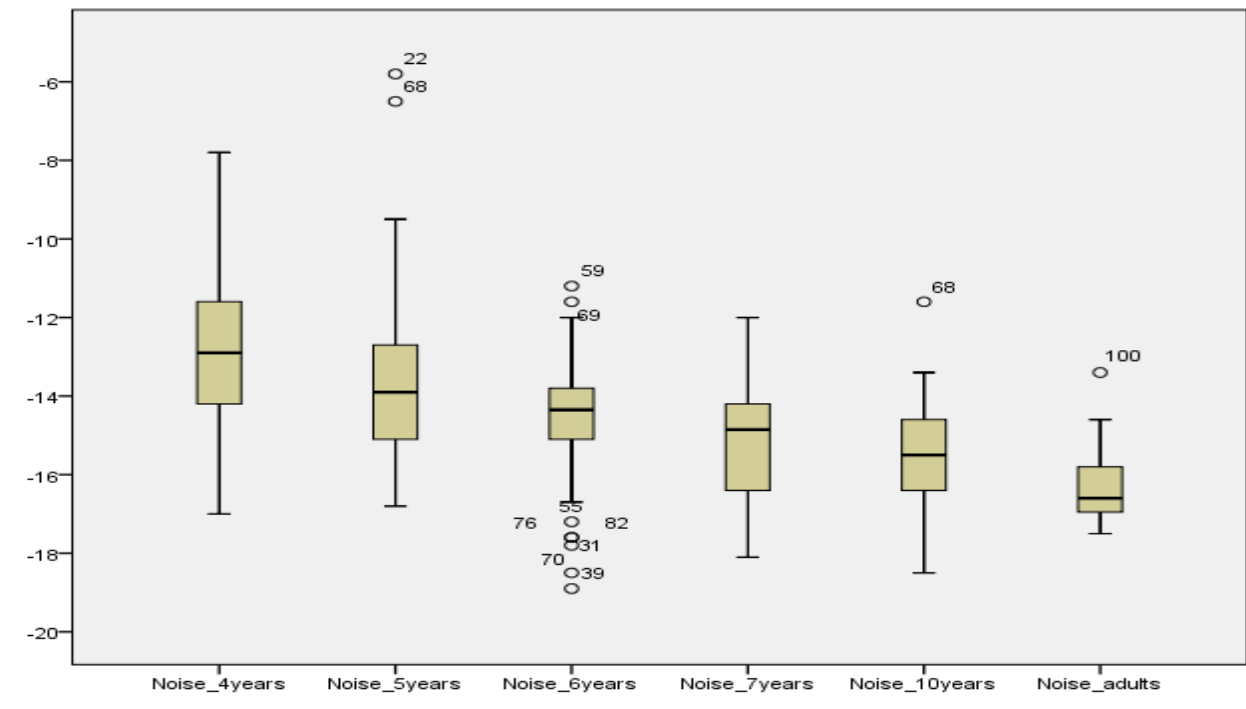
Figure 8. Comparison of mean SRT values in noise across age groups.